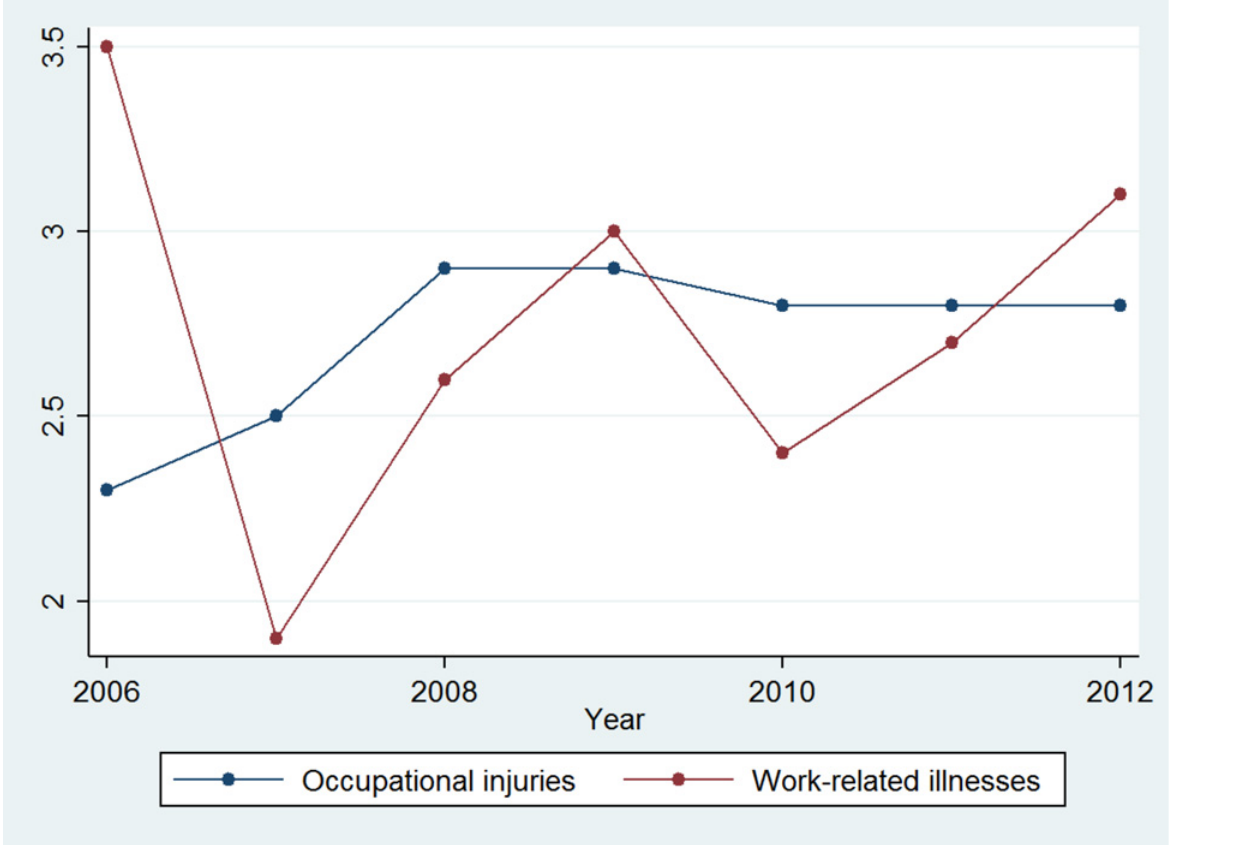
Fig 1. Rate of work-related illnesses and injuries per 100 employees, in the IMSS, 2006 to 2012.